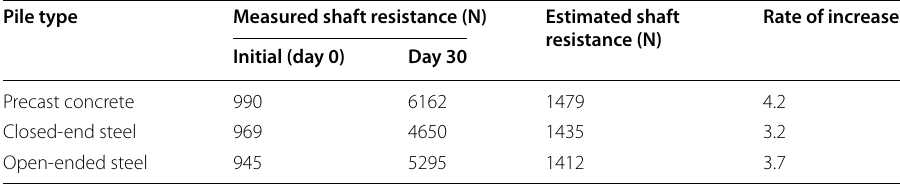
Table 2 Summary of measured and estimated shaft